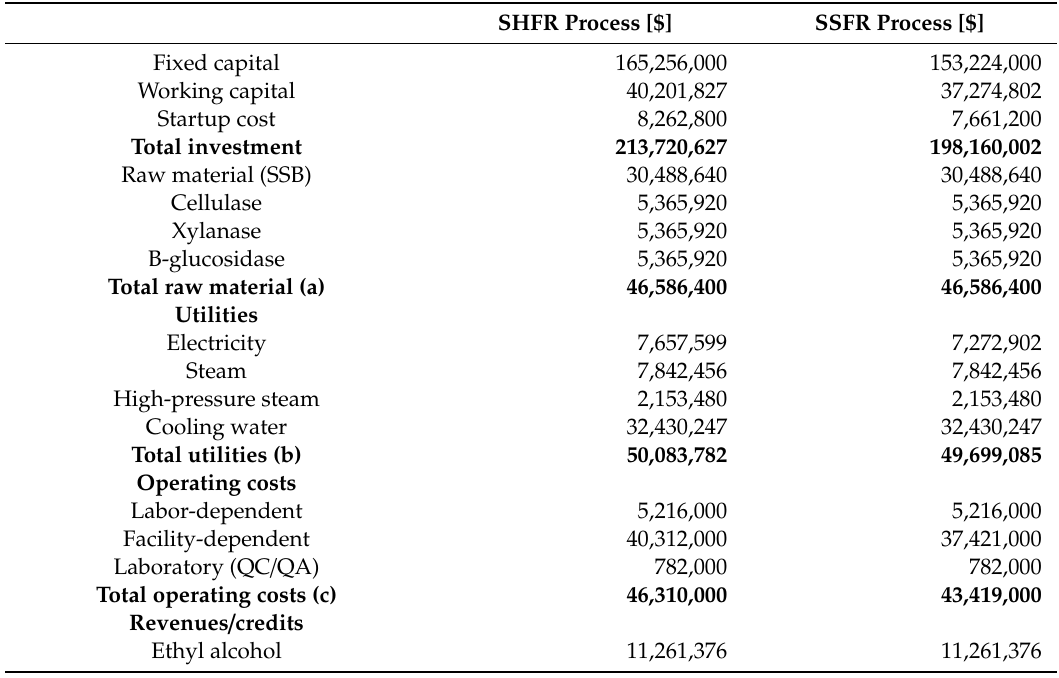
Table 2. Cost comparison of butanol production from SSB employing separate hydrolysis, fermentation, recovery (SHFR), and simultaneous saccharification, fermentation, and recovery (SSFR)